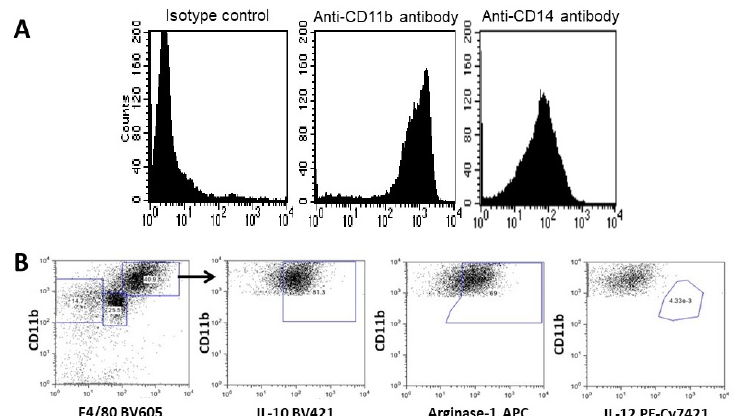
Figure 3. Flow cytometry of cells recruited into PVA sponge discs containing α -gal nanoparticles. ( A ) The large majority of the cells is macrophages as indicated by the staining of most cells with antibodies to two biomarkers of macrophages, CD11b and CD14. No staining was observed for T or B lymphocytes (not shown). ( B ) Analysis of the recruited macrophages state of polarization. The large size macrophages (CD11b pos /F4/80 pos ) were positive also for IL-10 and Arginase-1 but were negative for IL-12, implying that the majority of the recruited cells were M2 macrophages. Modified from ref. [57].